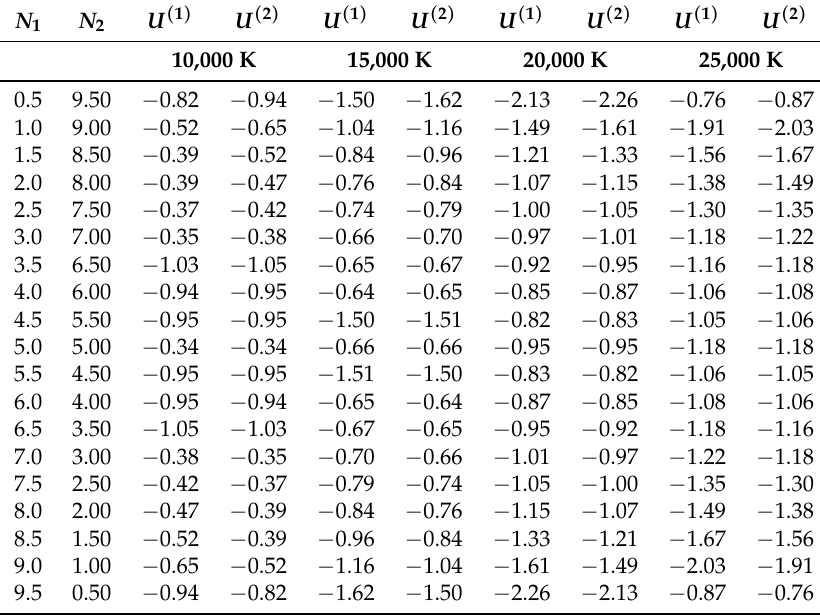
Table 4. The same as in Table 3 but for the case of Z 1 = Z 2 =